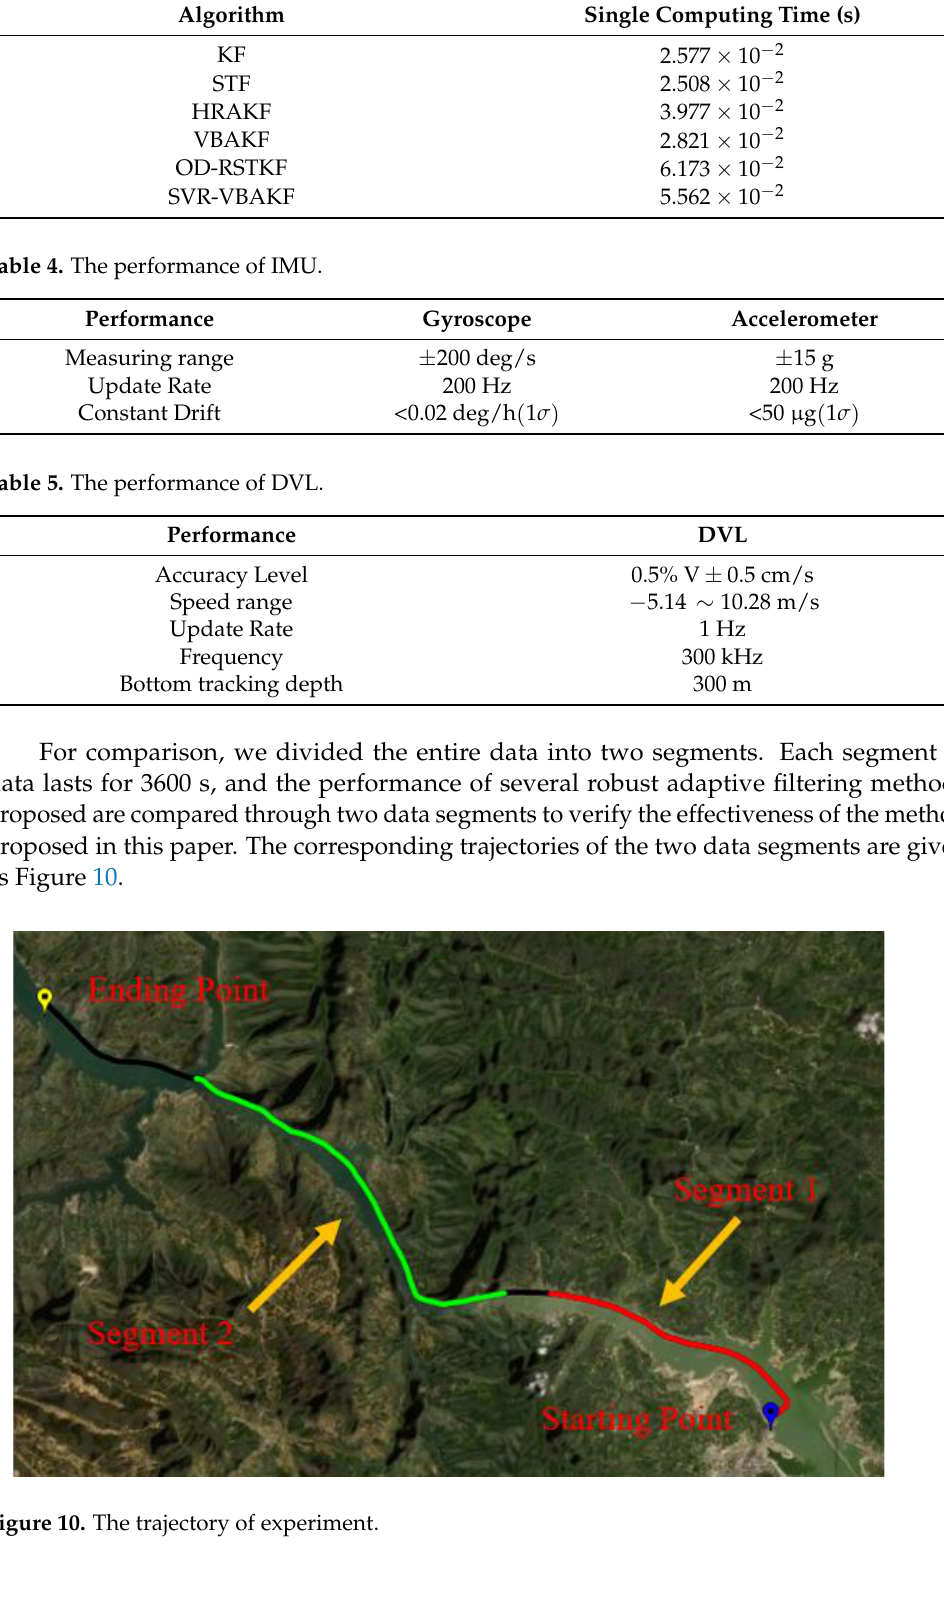
Table 3. Monte Carlo Simulation Single Computing Time. Table 4. The performance of IMU.